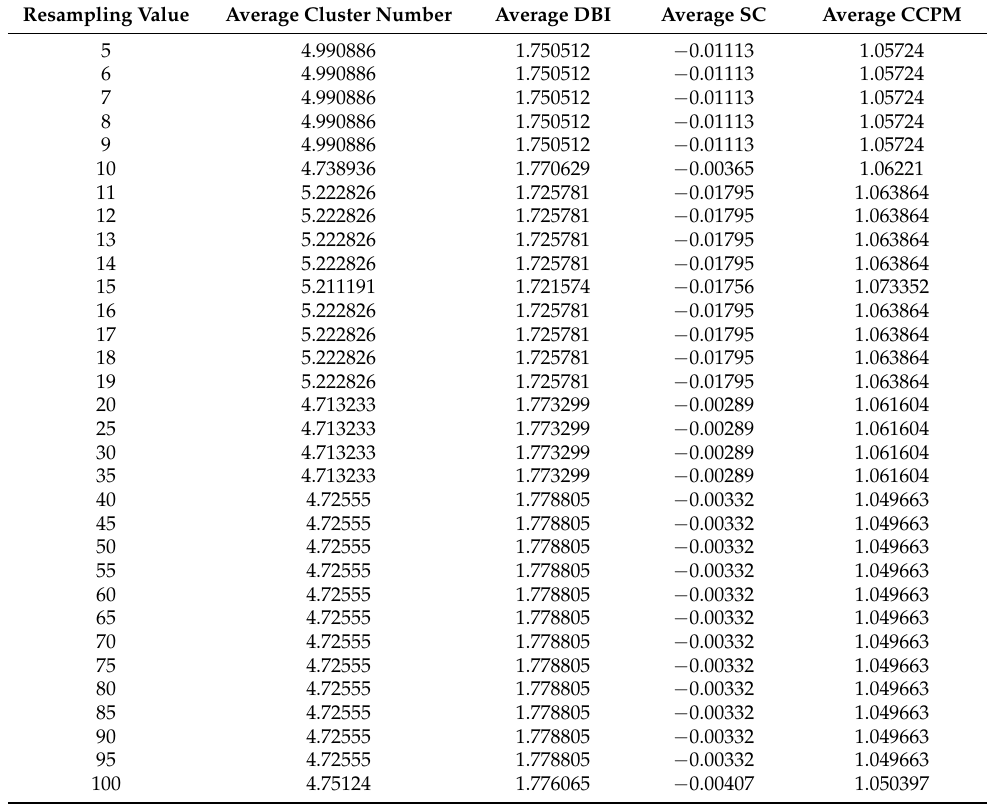
Table 5. Quantitative evaluation of ship trajectory clustering from Kaohsiung Port to Xiamen Port with different resampling